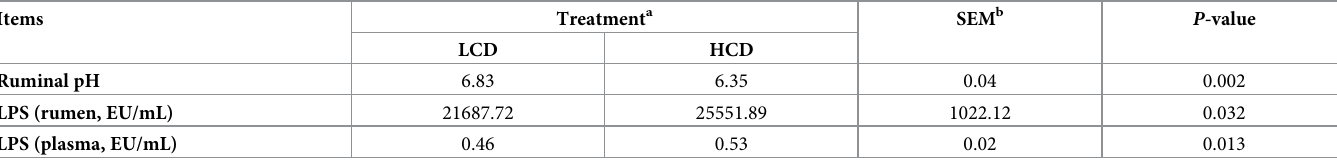
Table 3. Ruminal pH and the rumen fluid and plasma lipopolysaccharide (LPS)